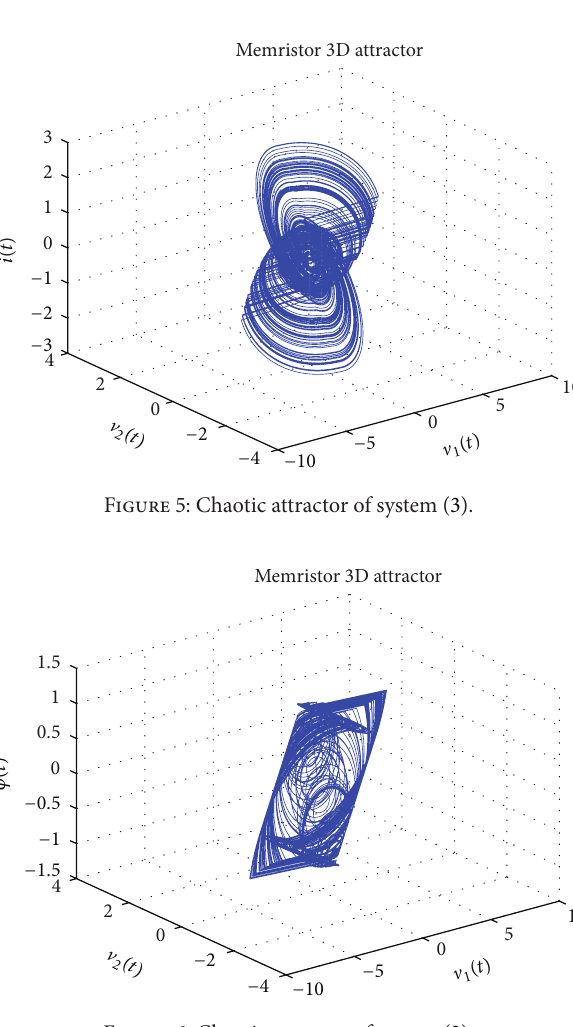
Figure 6: Chaotic attractor of system